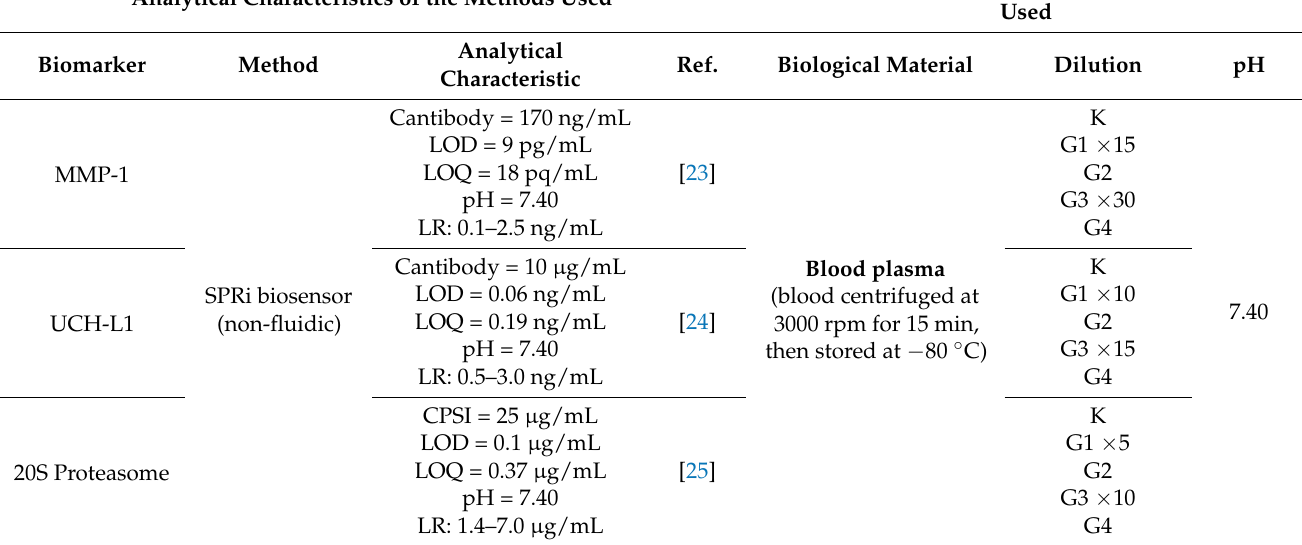
Table 3. Characteristics of analytical methods and procedures used to quantify the concentration of the tested proteins. Characteristics of the Quantification Procedures Analytical Characteristics of the Methods Used